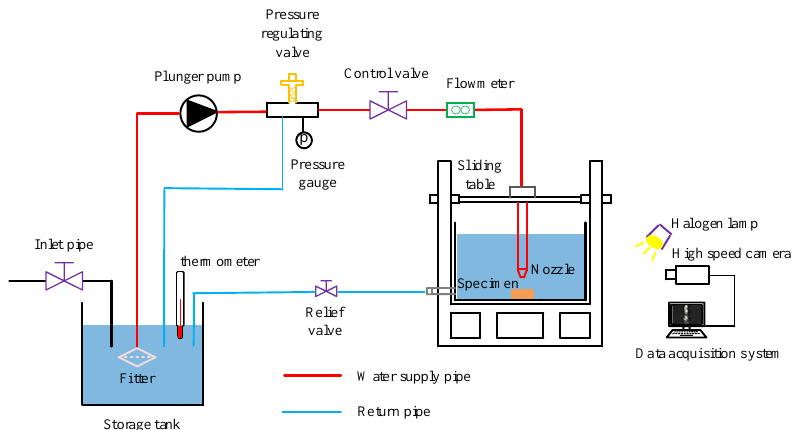
Figure 1. Schematic diagram of the submerged cavitation jet experimental system.